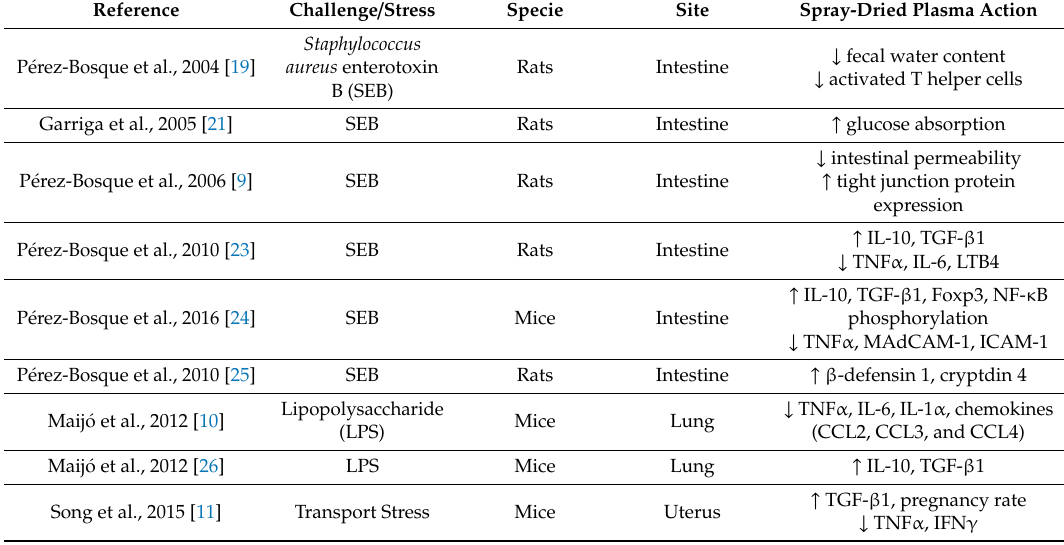
Table 1. Summary of spray-dried plasma mode of